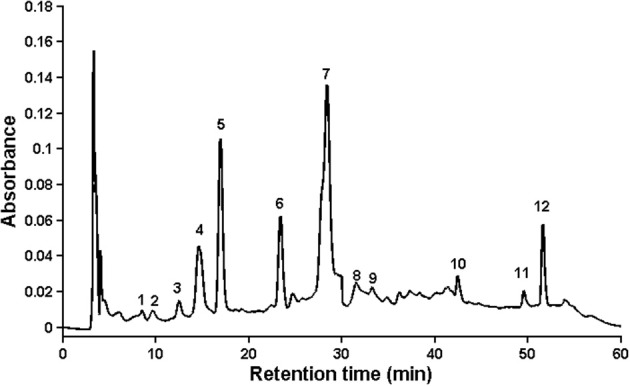
Chromatographic fingerprint by HPLC/UV at 254 nm.